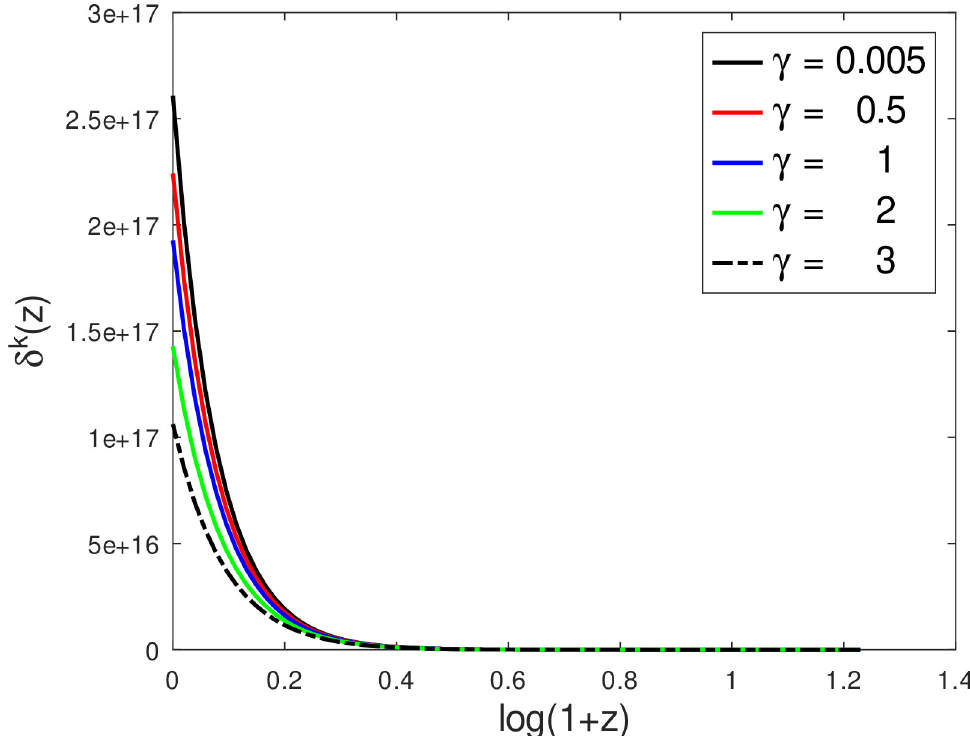
Figure 6. The variation of the matter density perturbations δ k ( z ) for a viscous Bianchi type-V cosmological model vs. redshift for long wavelength. The same initial conditions as the previous figures are used, but this time with viscosity included.